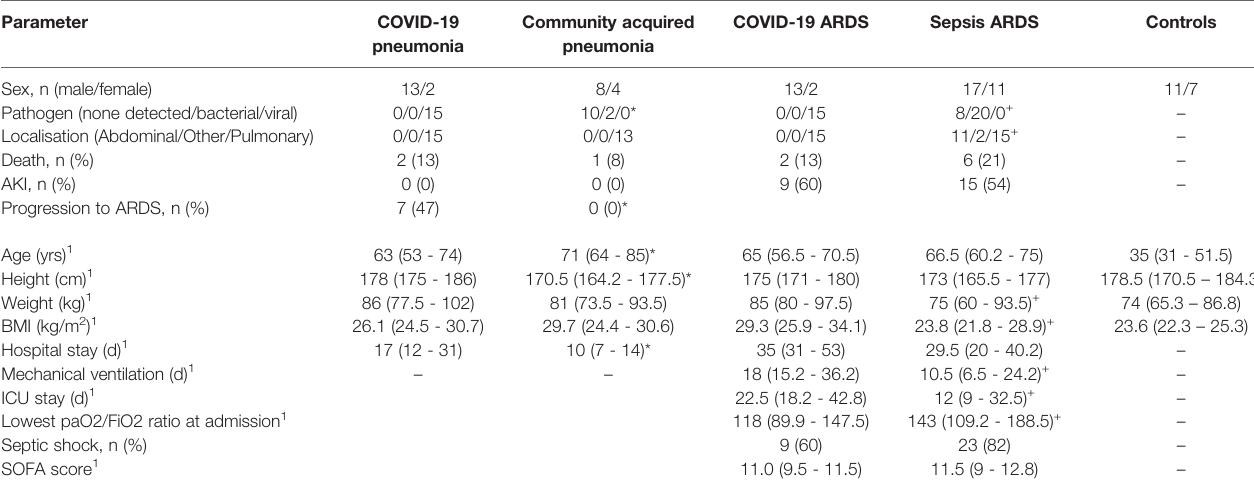
TABLE 2 | Characteristics of patients with successful